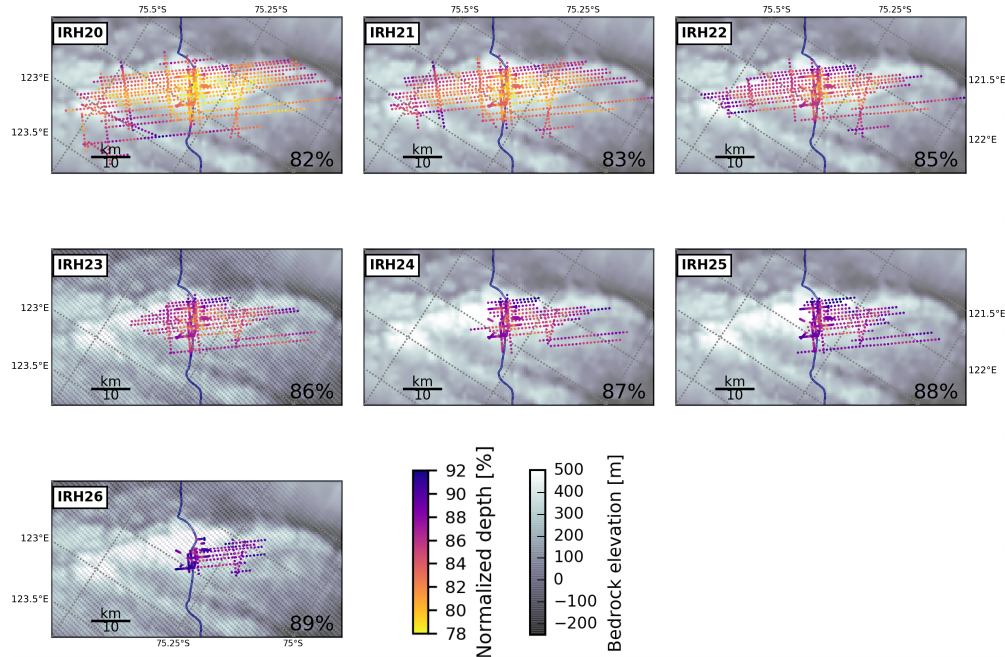
Figure 7. Spatial distribution of undated IRH depths over the LDC highland plateau on the East Antarctic Plateau, overlain on Young et al. (2017) bed elevations. The area covered by each panel is outlined by a black dashed box in the first panel of Fig. 6. The color scale represents the depth of the IRHs normalized by the ice thickness, both measured from the radar returns. The navy blue line outlines the position of the ice divide (Zwally et al.,